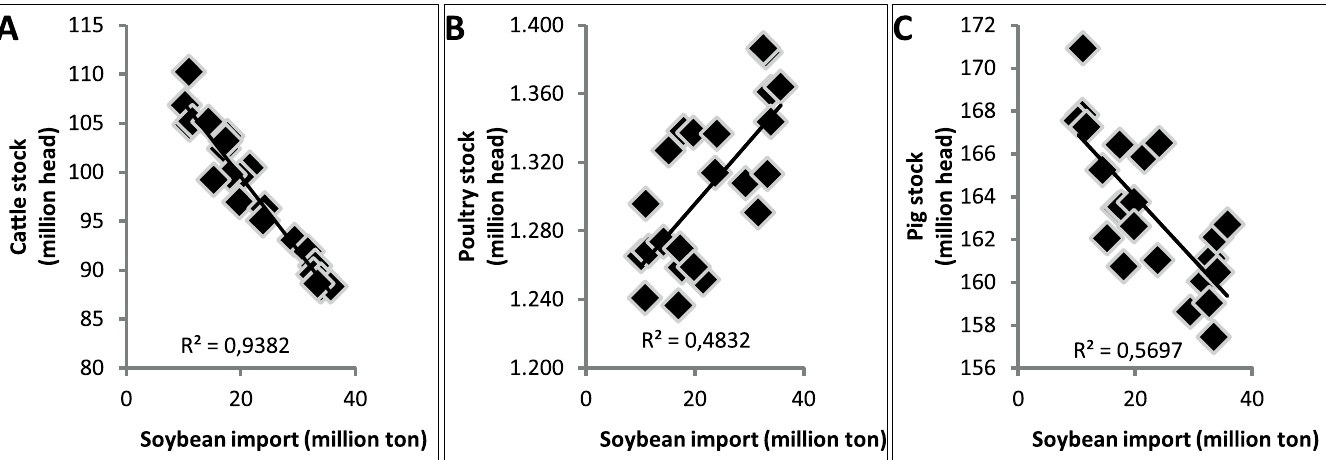
Fig 3. Correlation between European soybean import from Brazil and Argentina (soybeans and cake of soybeans) and European cattle stock (A), poultry stock (B) and pigs stock (C), 1986 – 2008 [21,34]. Correlation coefficients respectively: -0.97; 0.69; -0.75.